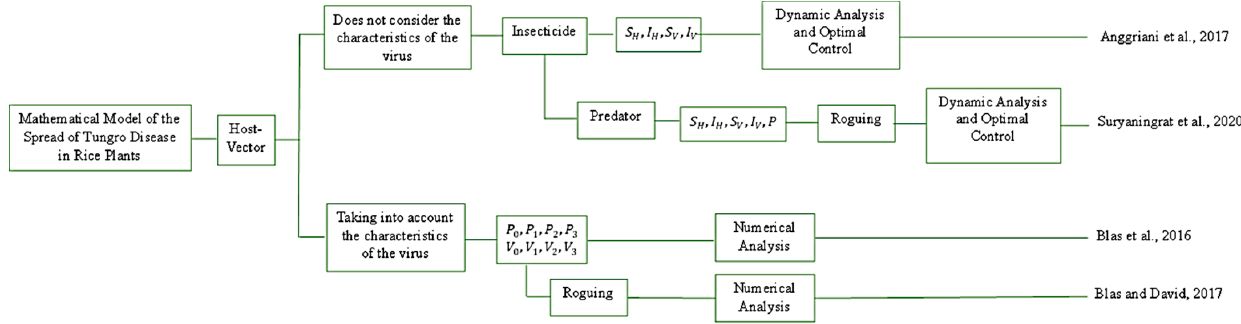
Figure 7. Phylogenetic Tree Diagram Mathematical Model of Tungro Disease Spread in Rice Plants [19–22].